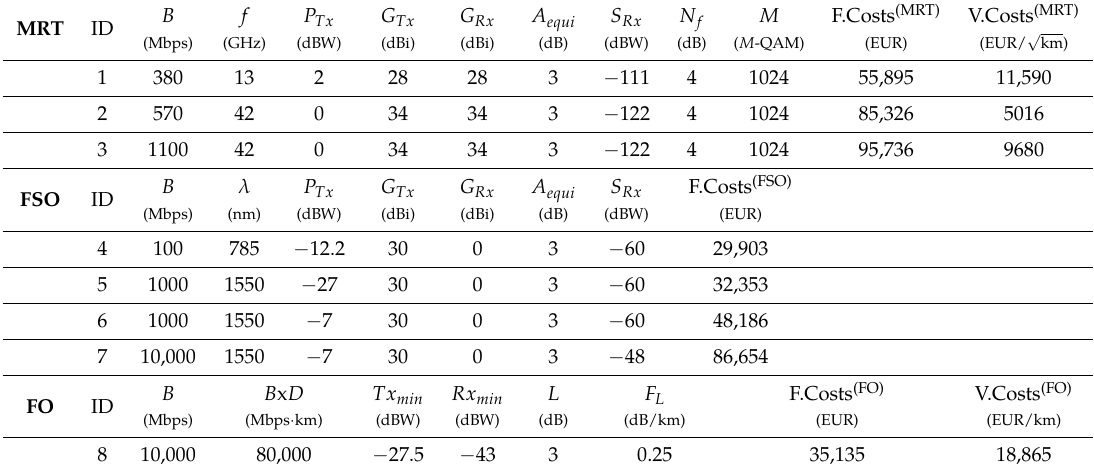
Table 6. Characteristics of the test